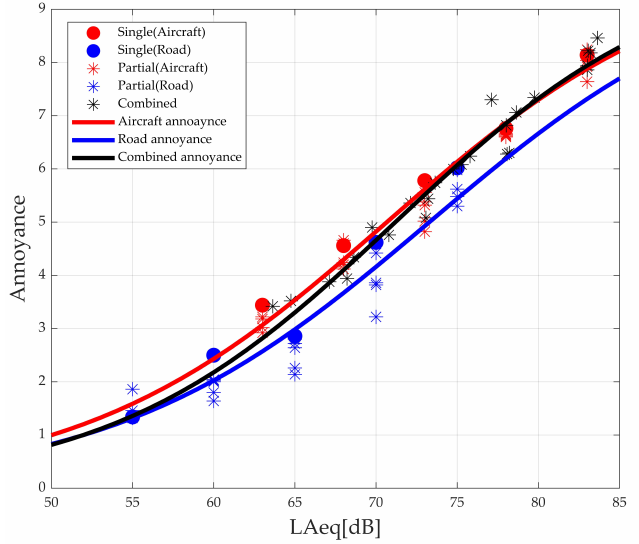
Figure 13. Annoyance evaluation results according to the noise level.